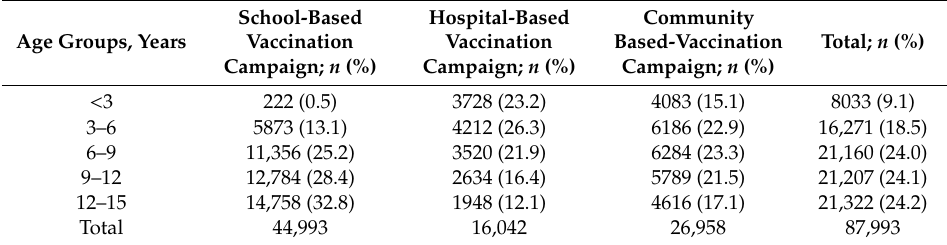
Table 3. Age breakdown of the children vaccinated in Lyari Town.